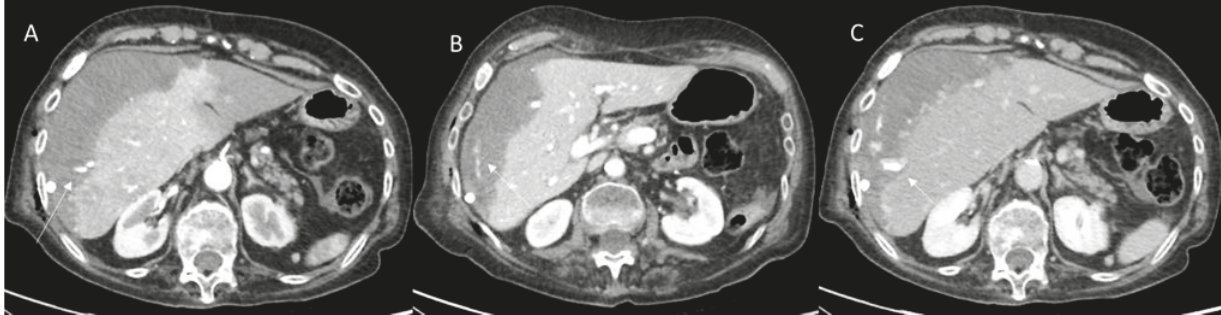
Figure 1. Woman 65 year at 7-day follow-up after RFA of liver metastases. CT assessment (( A ): arterial phase; ( B ): portal phase and ( C ): late phase): active bleeding (arrow).